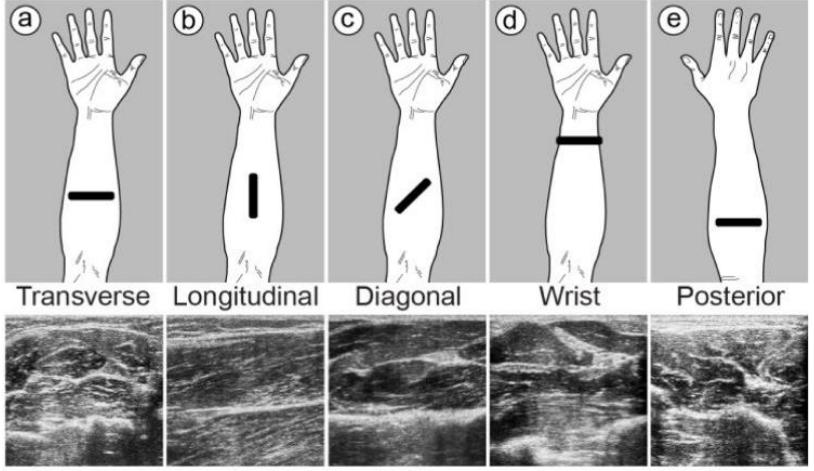
Figure 5. ( a – e ) A comparison of the ultrasound probe ’ s various hand mounting positions, along with the related picture